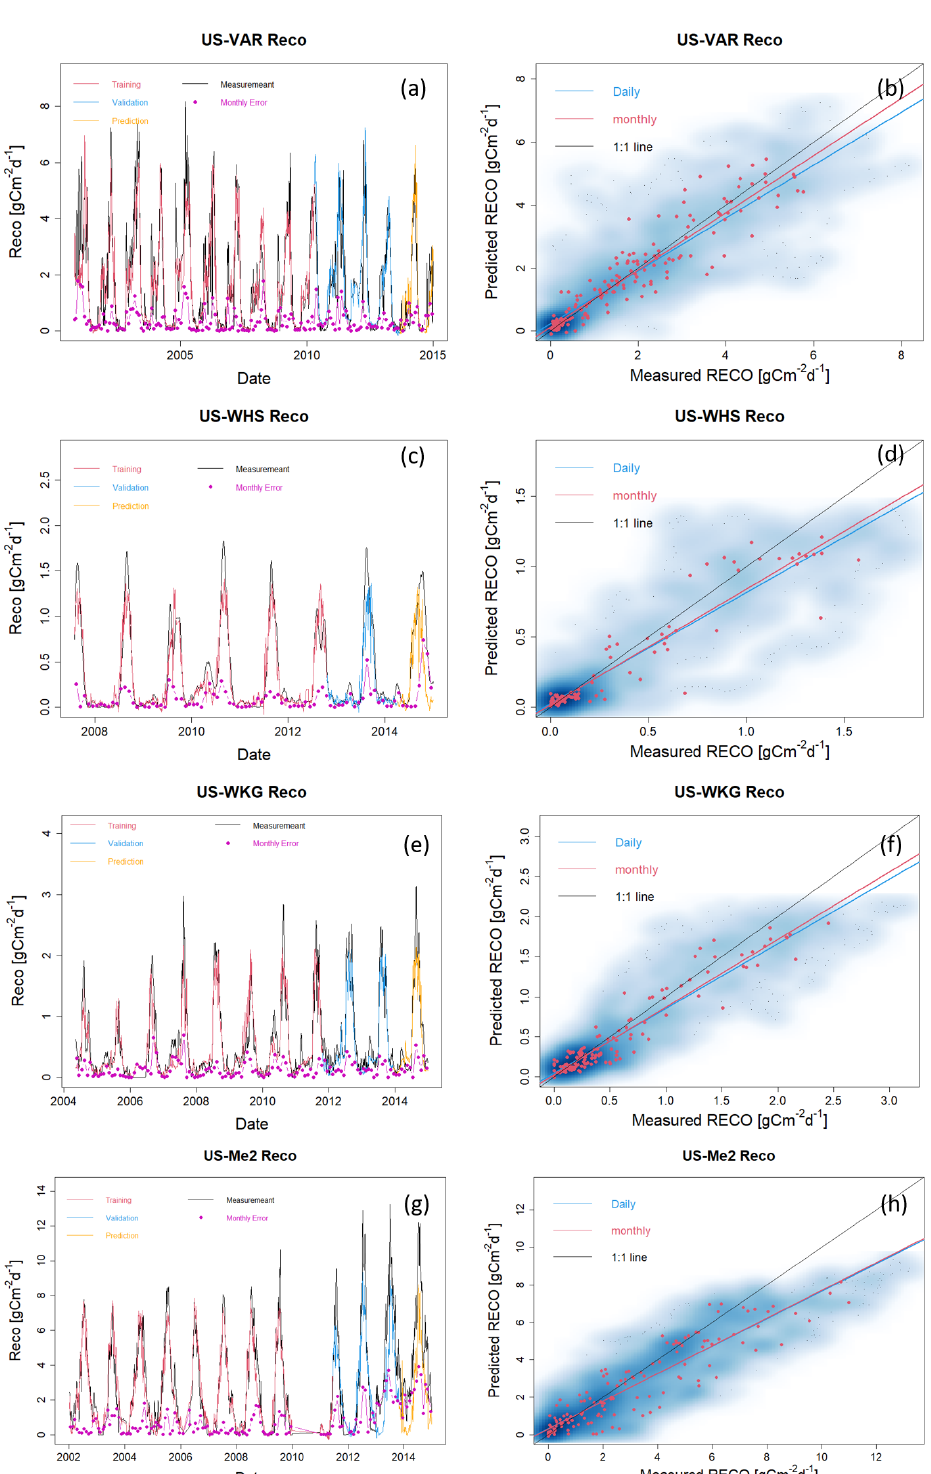
Figure A4. R eco estimation with data from selected FLUXNET sites at US-Var, US-Whs, US-Wkg, and US-Me2. Panels (a) , (c) , (e) , and (g) present daily estimations of R eco separated for training, validation, and prediction. Pink points depict monthly error between HPM estimation and FLUXNET data. Panels (b) , (d) , (f) , and (h) show the scatter plots of daily (blue) and monthly (red) R eco . Darker blue clouds represent a greater density of data